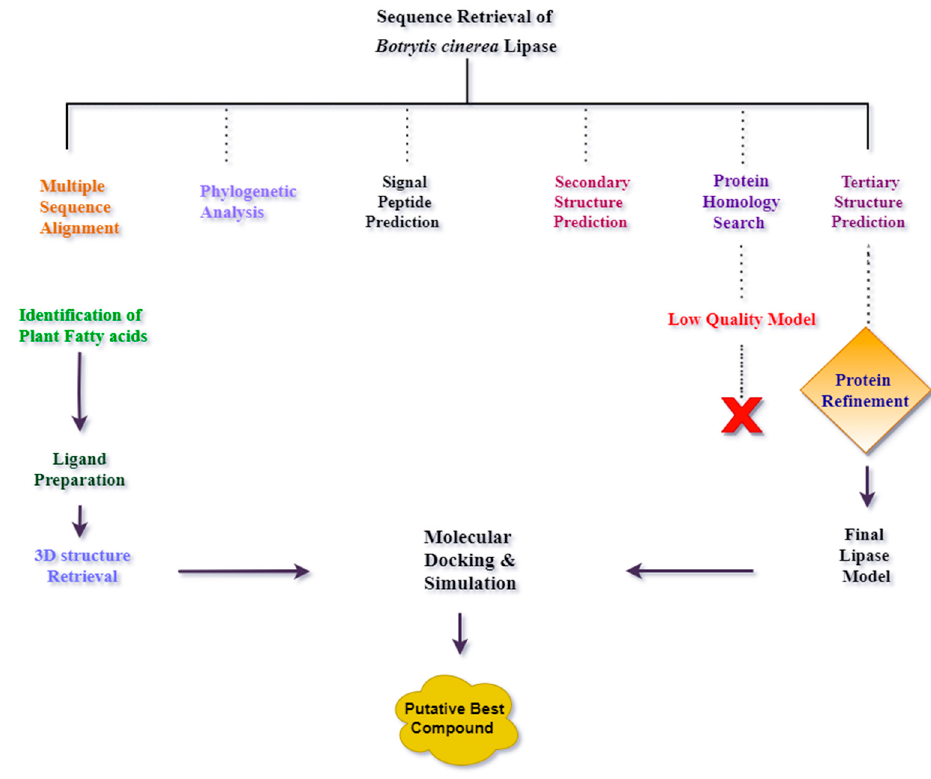
Figure 14. A detailed flowchart of the methodology used in this study.